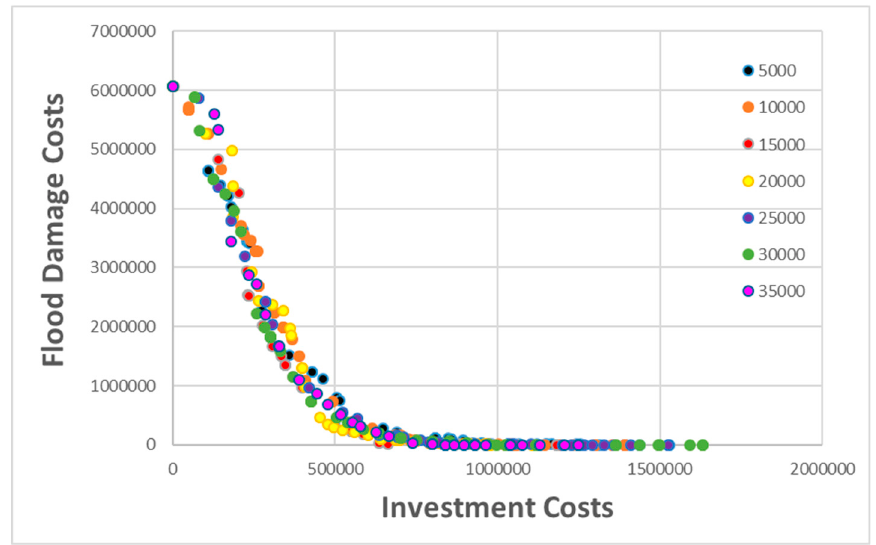
Figure 9. Pareto front representation of model SSR 2 (29T39C) and seven di ff erent numbers of generations.